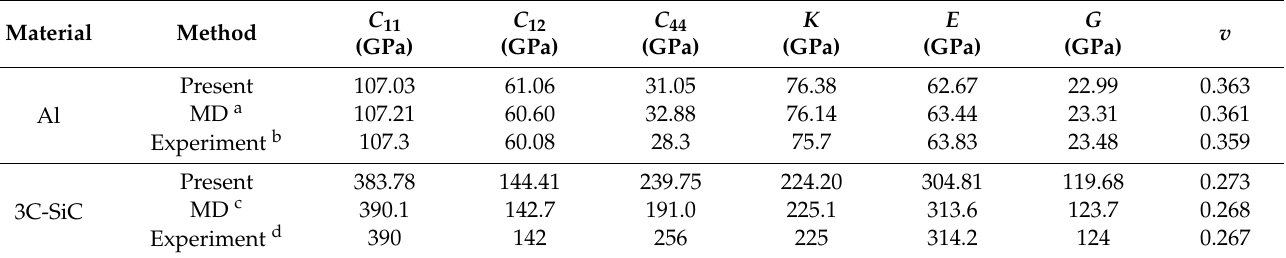
Table 1. Elastic constants, bulk modulus, Young’s modulus, shear modulus, and Poisson’s ratio obtained by the present MD simulations using the EAM and Tersoff potential functions and compared with those obtained by other MD or experimental